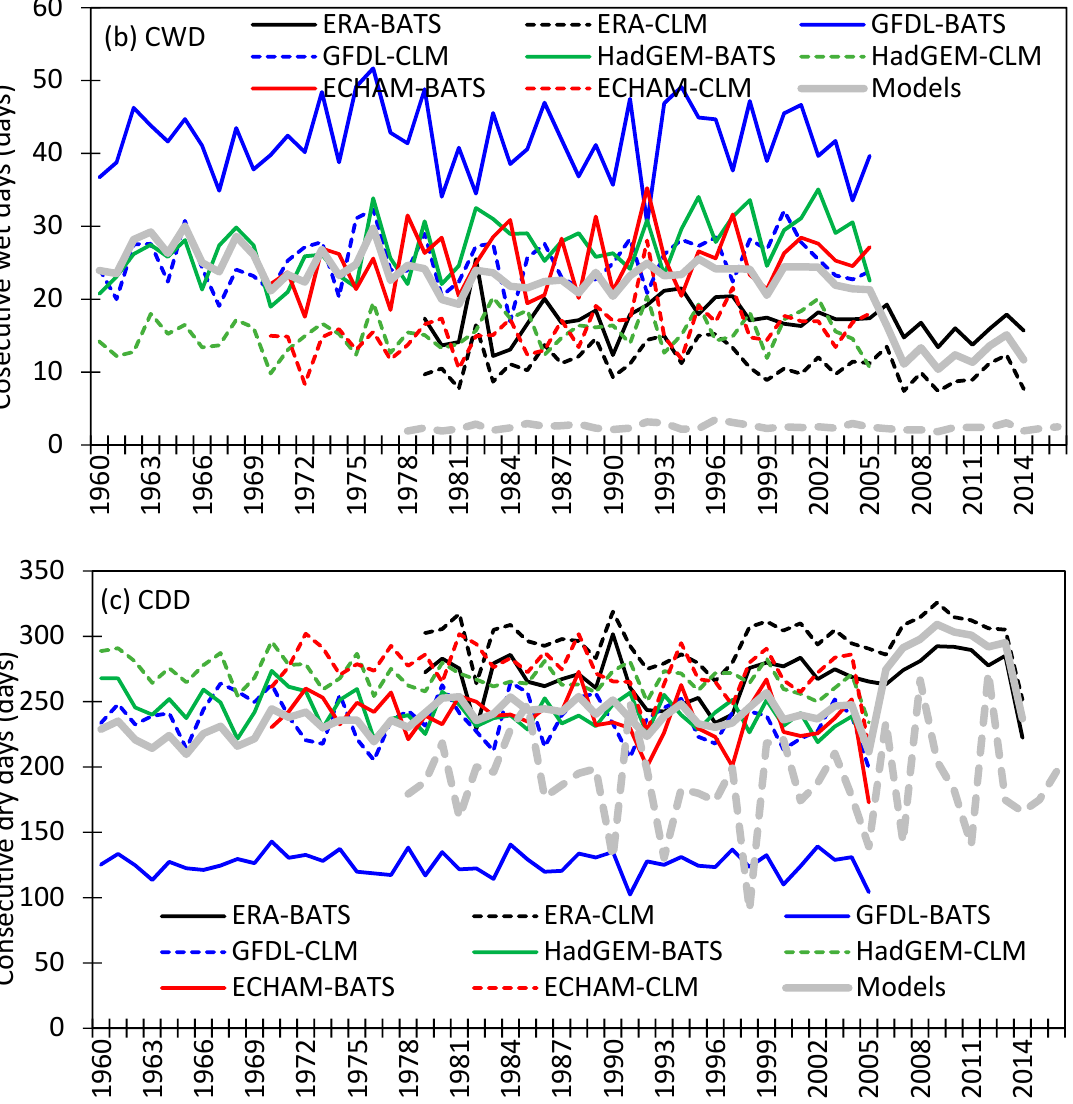
Figure 14. Comparison of simulation based precipitation indices ( a ) number of wet days, ( b ) consecutive wet days, and ( c ) consecutive dry days, with the same obtained from observations for the entire period of data available corresponding to each dataset.